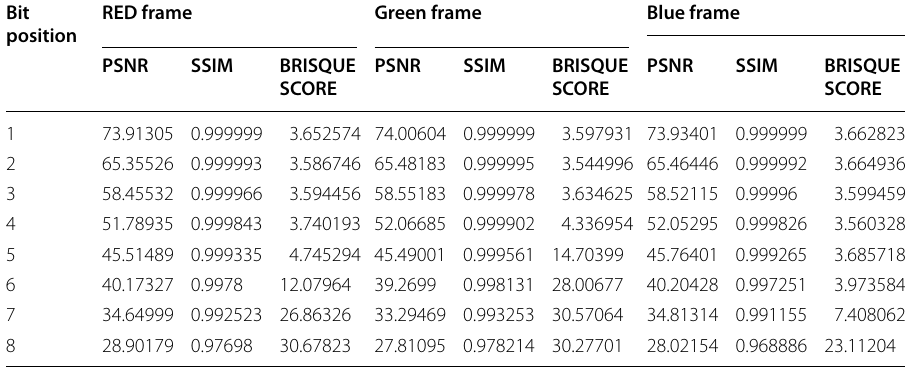
Table 3 Visual quality metrics of watermarked RGB color image vs. host RGB color image